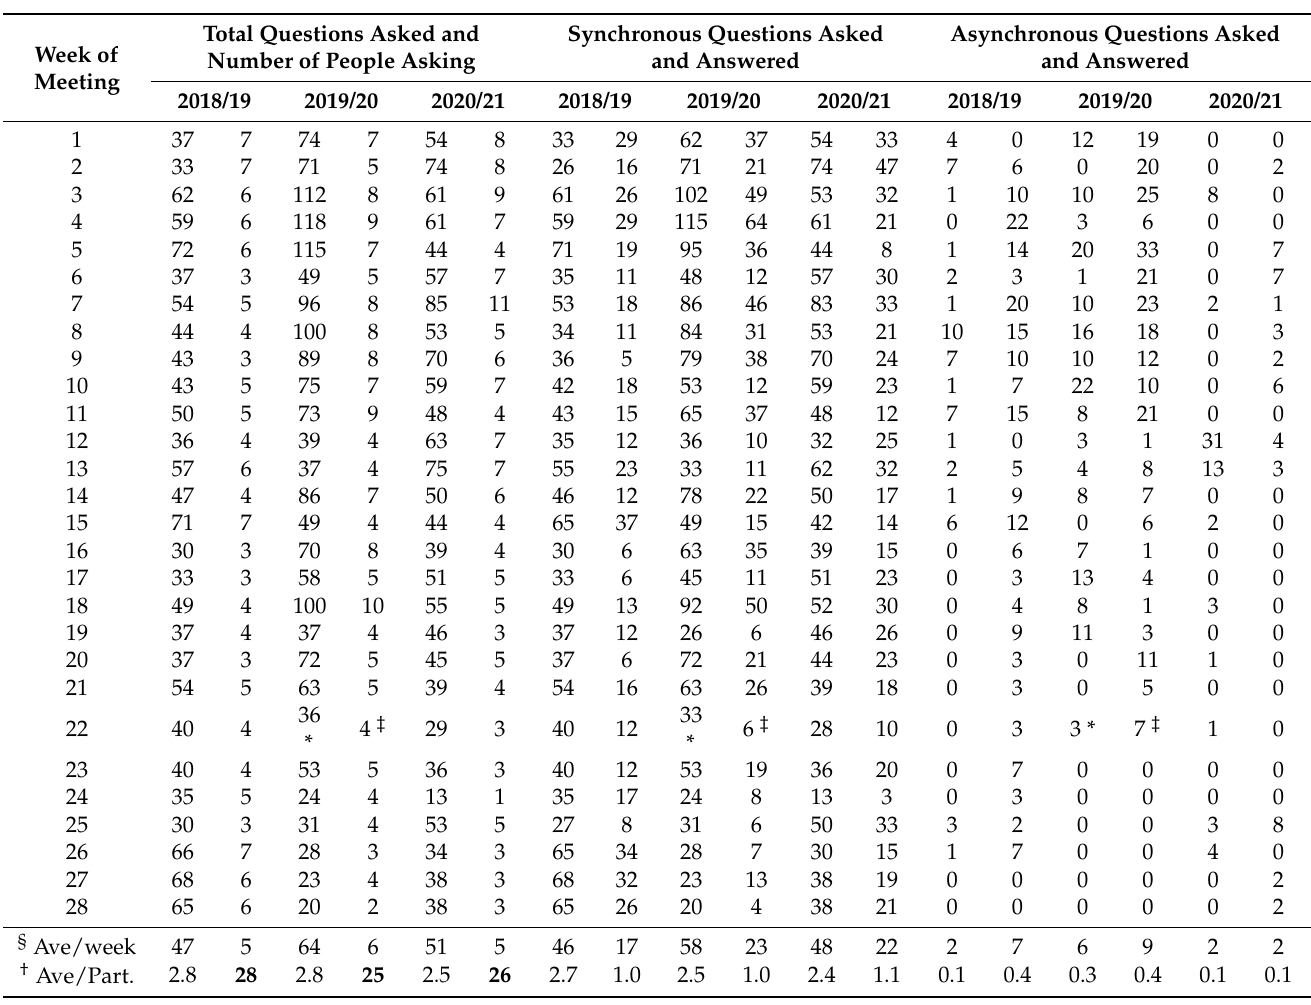
Table 7. Total Number of Questions Asked and the Number of People Posing Questions, Those Doing So Synchronously during the Health Narratives Research Group Meeting (Pre-COVID-19 in Person, after 12 March 2021, Online), and Those Asking and Answering Asynchronously through the Private Facebook Group, over the Three Most Recent Academic